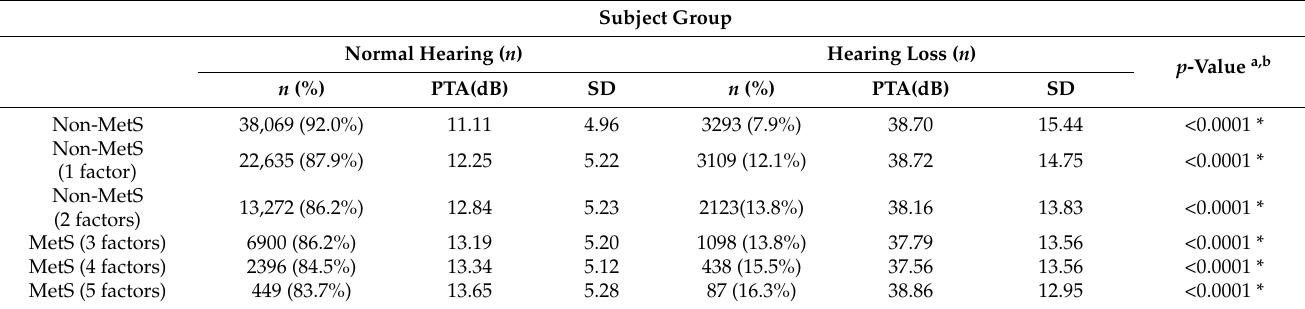
Table 4. Comparison of the groups of subjects with normal hearing and hearing loss.